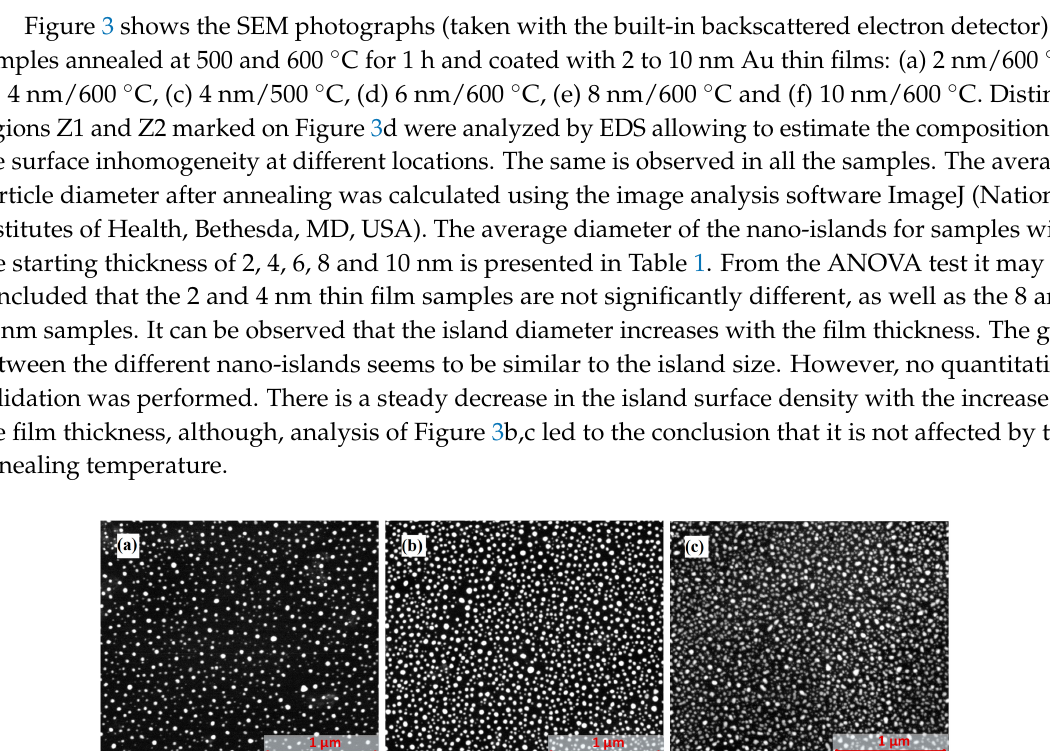
Figure 2. Scanning Electron Microscope (SEM) photograph of a sample coated with 6 nm thick gold thin film: ( a ) before and ( b , c ) after annealing at 600 °C for 1 h.